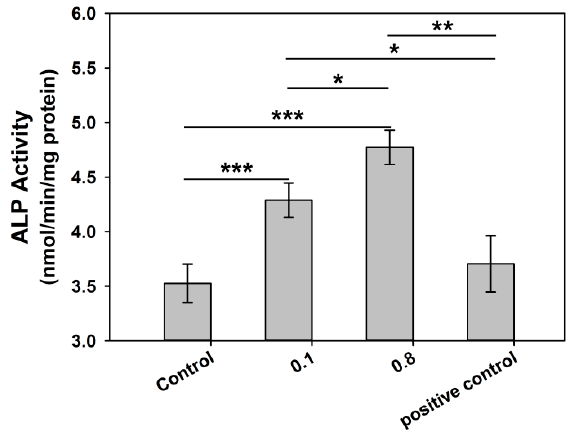
Figure 8. ALP activities of MC3T3-E1 cultured with different concentrations of Rod-CC NPs, and the osteoinduced medium without nanoparticles was employed as positive control. (* p < 0.05, ** p < 0.01, *** p < 0.001; n = 5).